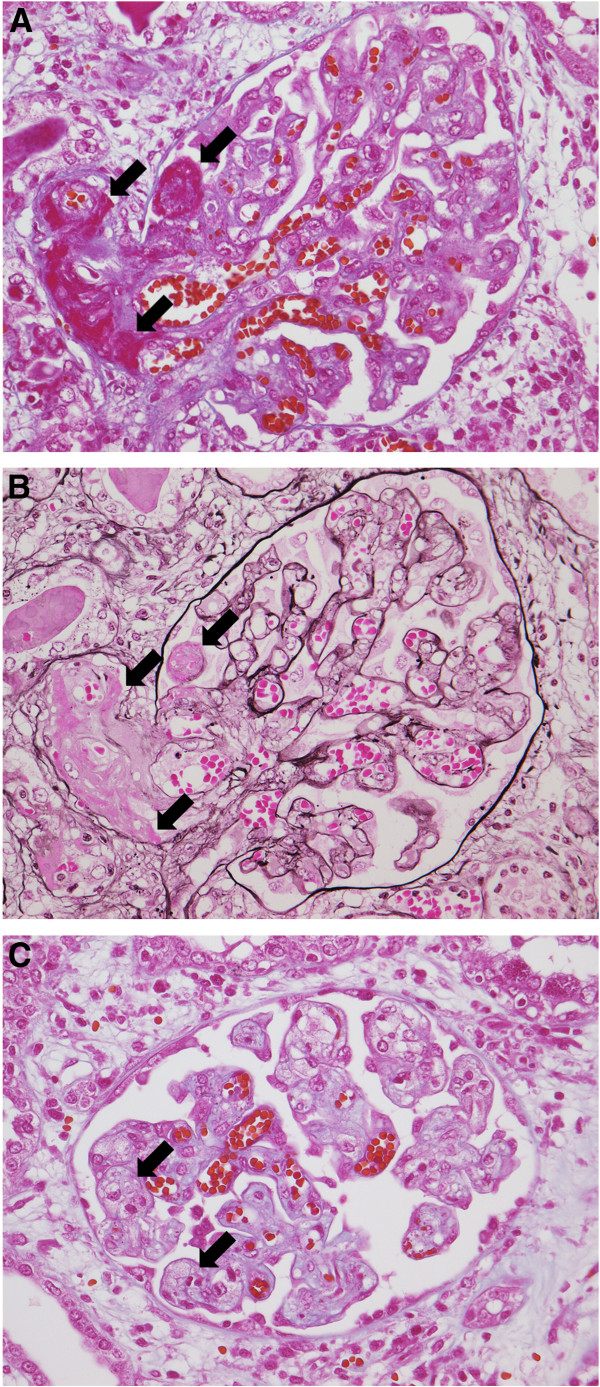
Renal histopathological findings. A, B: Fibrin thrombi in small arteries (arrows) and a glomerulus containing numerous red blood cells (A: Heidenhain's azan trichrome stain, B: Periodic acid methenamine silver stain × 400). C: Endothelial cell swelling (arrows) (Heidenhain's azan trichrome stain × 400).